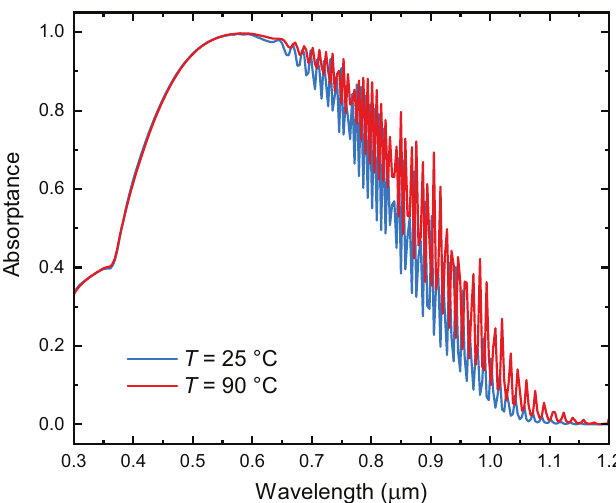
Fig. B.1. Absorptance of silicon (i.e., absorption in silicon nitride and aluminium are not shown) up to 1.2 m m calculated for the reference cell. The absorptance spectra is shown for two cell temperatures.